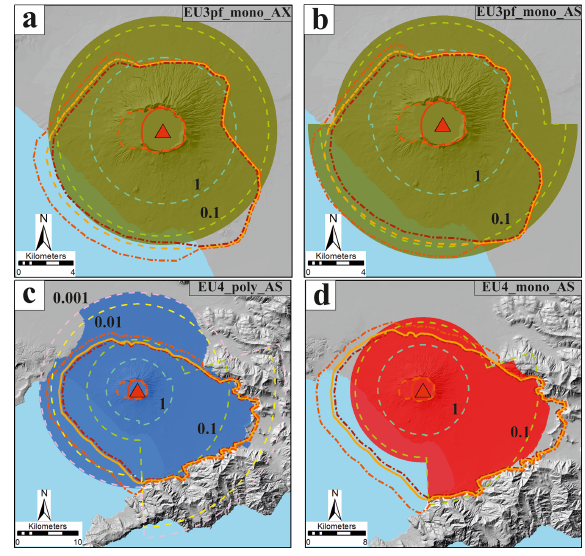
Figure 7. Comparison between simulations (dashed lines) assuming different initial volumetric fractions of solid particles ( ε 0 ) and the actual deposit (solid line) of the (a) EU3pf unit S and (b) EU4b/c unit SE. In (b) , the inset is a magnification of the thicknesses more than 9km from the vent.